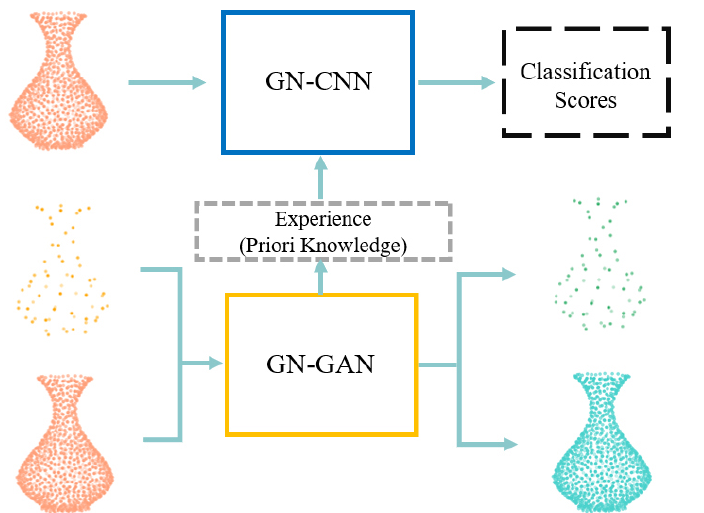
Figure 1. The overall architecture for warm starting GN-CNN by pre-training a GN-GAN. GN-GAN generates and captures prior knowledge as the experience knowledge (vector) of the point clouds. The experience vector is plugged into GN-CNN for warm starting. For GN-GAN, the left orange point clouds are the ground truth. We use two resolutions—the top is downsampled and the bottom is the original one; this helps to learn multi-scale point cloud features. The green point clouds are the generated